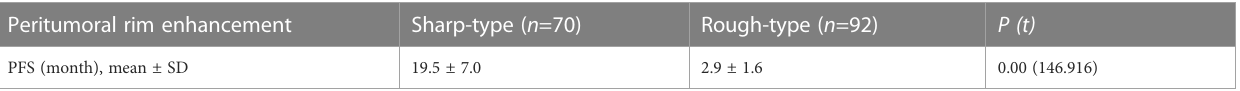
TABLE 2 Comparison of PFS between two types of peritumoral rim